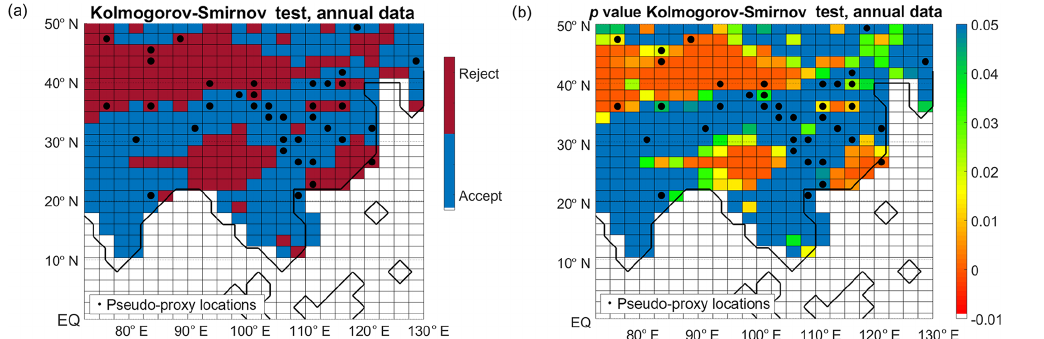
Figure A1. Kolmogorov–Smirnov normality test on the simulated JJA precipitation during the instrumental period (years 1906–2005, at annual resolution). (a) Rejection or acceptance of the normality hypothesis, at a 95% confidence level; (b) p values. Black dots: pseudo- proxy network.